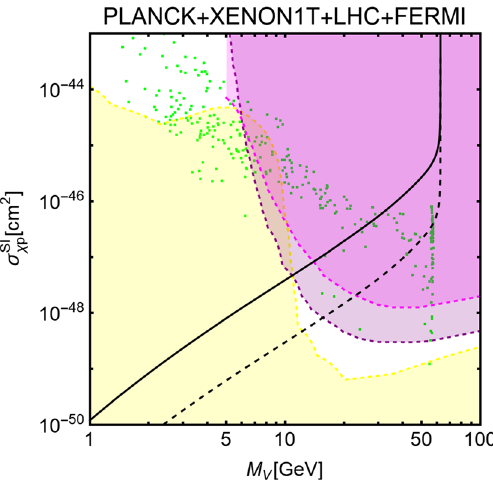
Fig. 13 The same as Fig. 10 for the dark U(1) model the four physical masses M H , M sequence of the discrete Z 2 symmetry, the lightest among the electrically neutral scalar bosons H 0 and A 0 will be the